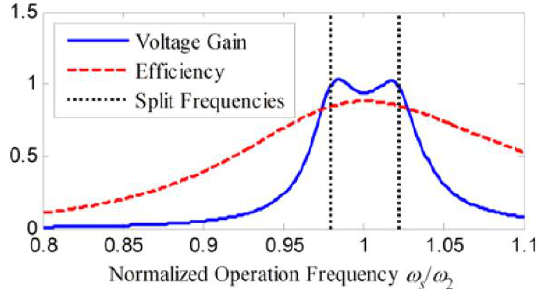
Figure 7. Illustration of the IPTS voltage gain and efficiency including split frequencies [16].